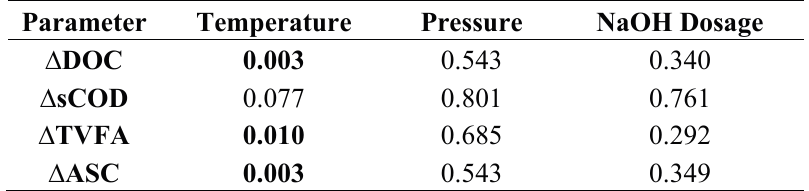
Table 2. ANOVA analysis: influence of factors (temperature, pressure and NaOH dosage) on each parameter.